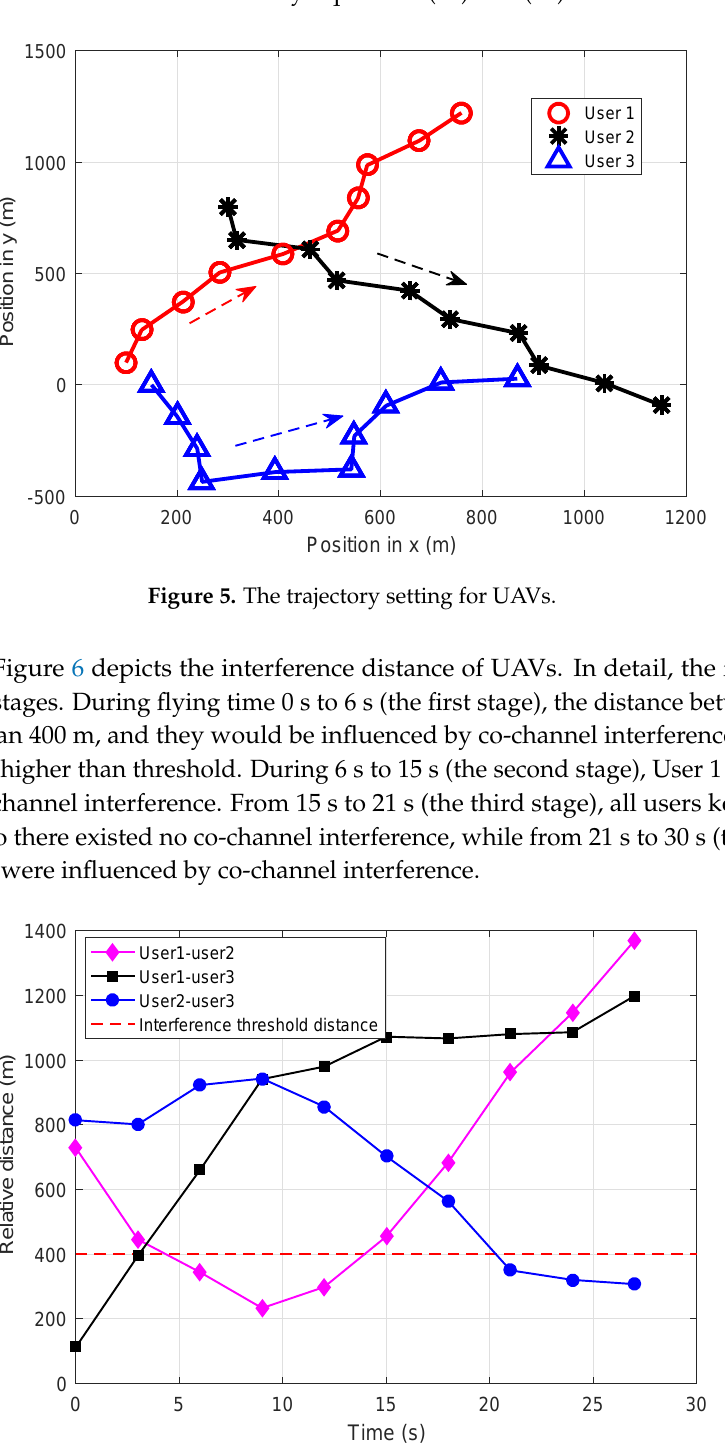
Figure 6. Relative distance variation